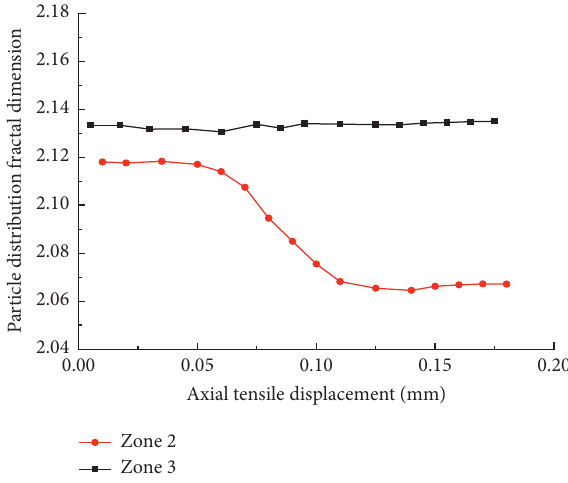
Figure 23: The change of pore distribution fractal dimension in Zone 2 and Zone 3.